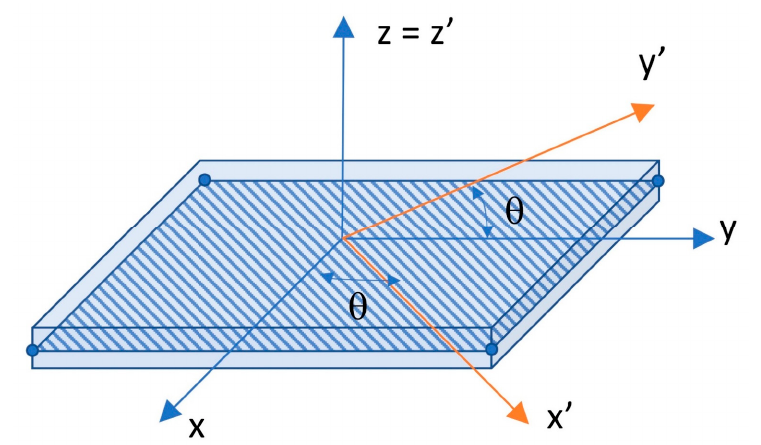
Figure 4. The local coordinate system of a single laminate.